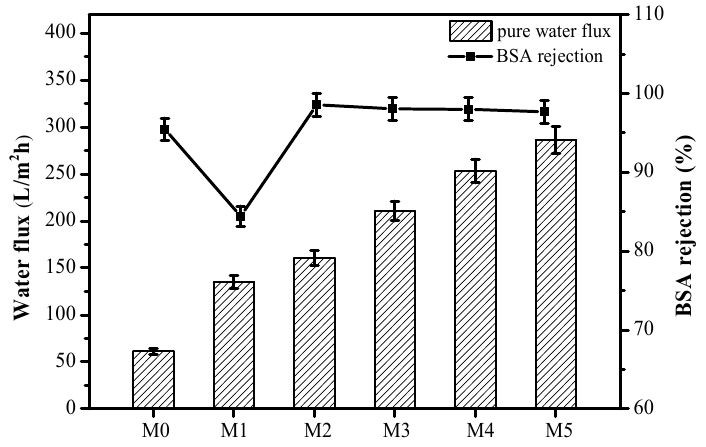
Figure 4. Water fluxes and BSA rejection of the ultrafiltration membrane.